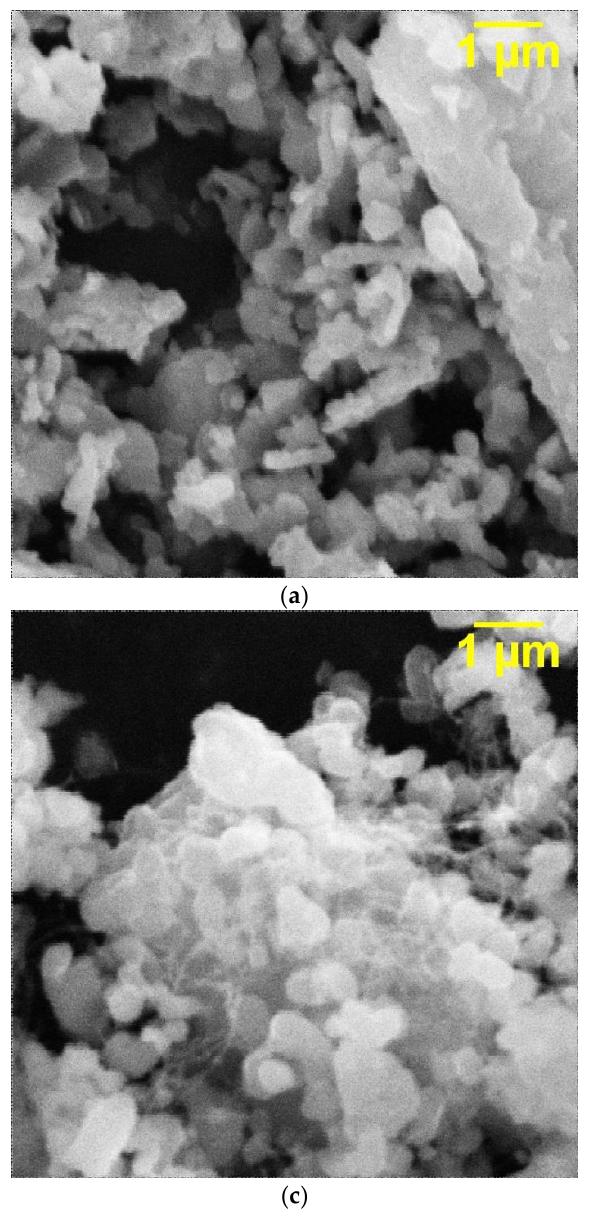
7 of 17 Figure 4. FTIR of the KFTO(H)/PVDF composites. The SEM microphotographs of the KFTO(H) ceramic filler, MWCNTs and their mix-